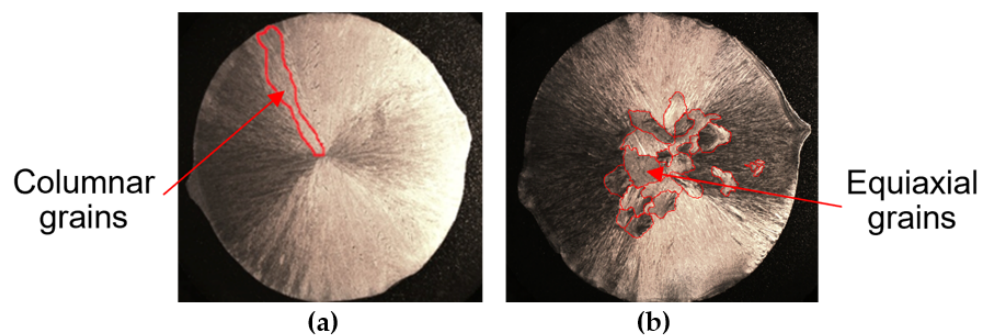
Figure 3. Macrostructure of as-cast high-chromium cast iron: ( a ) before inoculation; ( b ) after inoculation (with marked equiaxial grains) [21].